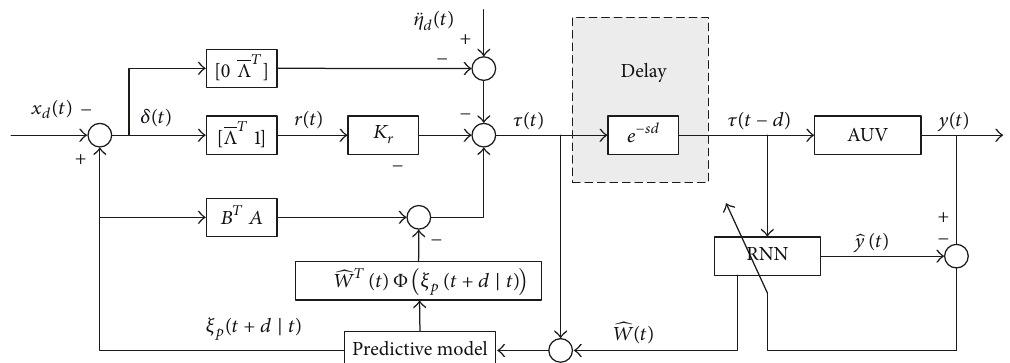
Figure 1: Control structure of AUV system